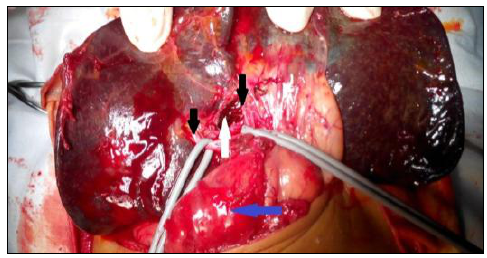
Figure 1: Intra-operative picture of portal dissection during Kasai procedure. Black arrows – right and left portal veins, White arrow – fibrous cone transected at porta, Blue arrow-Duodenum.